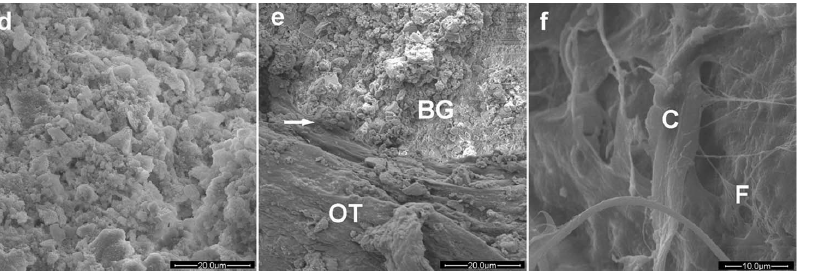
Figure 10. SEM images of the cement after implantation for 8 weeks in rabbit tibiae infected with MRSA-induced osteomyelitis. The BG implant became porous (a), was bonded to osteoid tissues (OT) at the interface (arrow) (b), and some cells (C) and fibrous tissue (F) adhered to the implant (c).